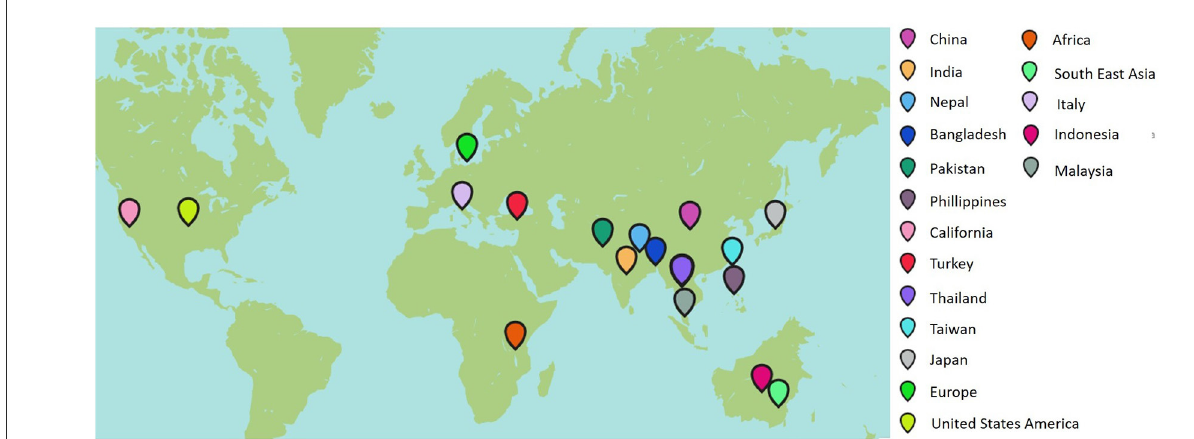
FIGURE1 Geographical distribution of the bakanae disease.